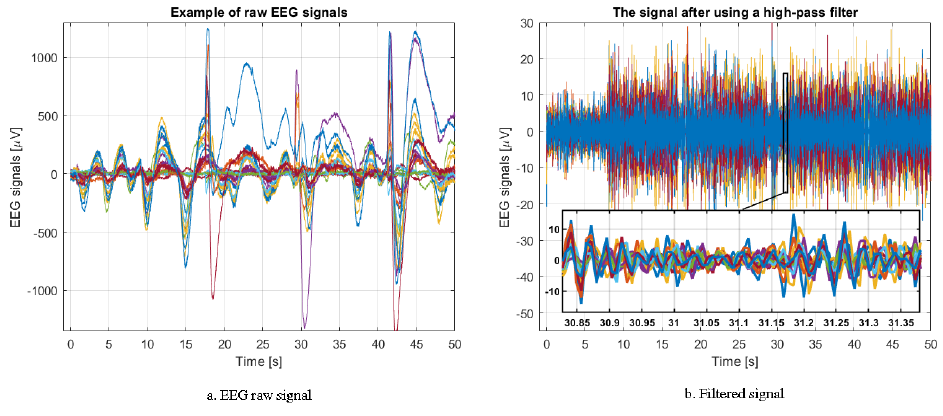
Figure 4. The observation of raw and filtered EEG